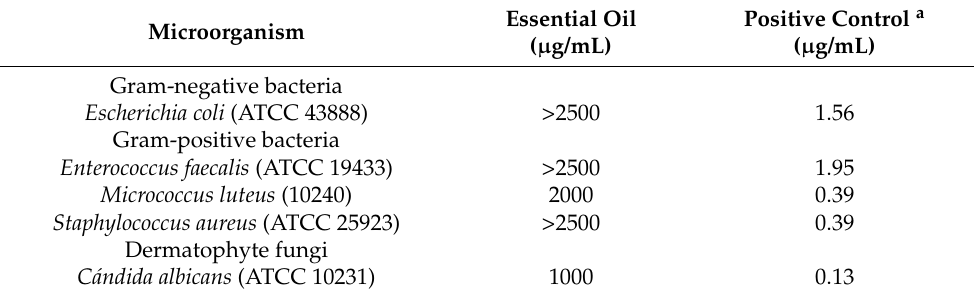
Table 2. Antimicrobial activity of the essential oil from Croton ferrugineus .